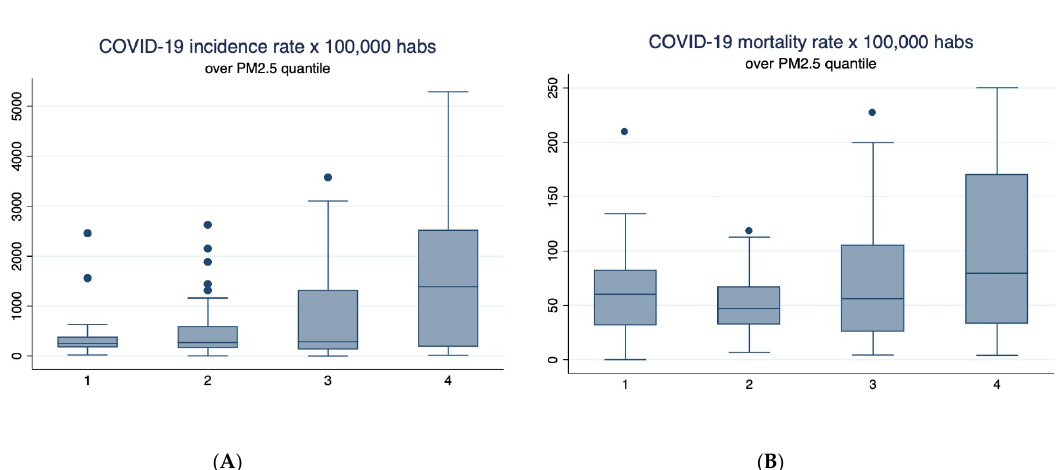
Figure 3. Box plot of COVID-19 incidence and mortality rate above quantile of PM 2.5 . ( A ) Relationship between quartiles of PM 2.5 and COVID-19 incidence rate × 100,000. ( B ) Relationship between quartiles of PM 2.5 and COVID-19 mortality rate × 100,000. The quartiles of PM 2.5 are 1: [2.06–7.46 µ g/m 3 ); 2: [7.46–14.12 µ g/m 3 ); 3: [14.12–22.60 µ g/m 3 ); 4: [22.60–65.43 µ g/m 3 ].